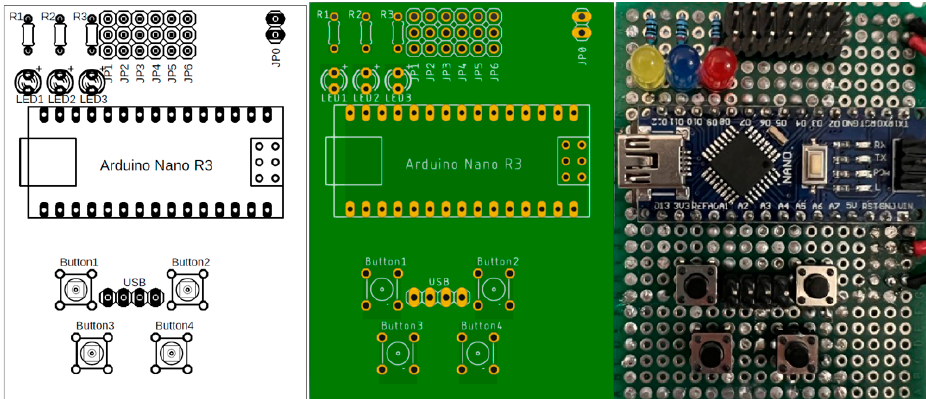
Figure 7. The design of the custom-made circuit board.